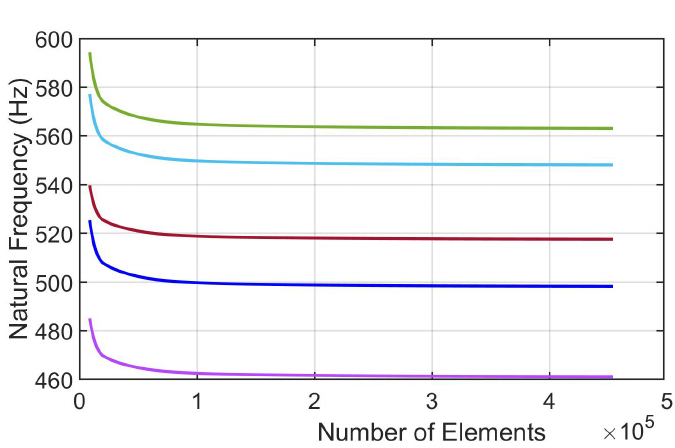
Figure 5. Mesh convergence plot for the first five natural